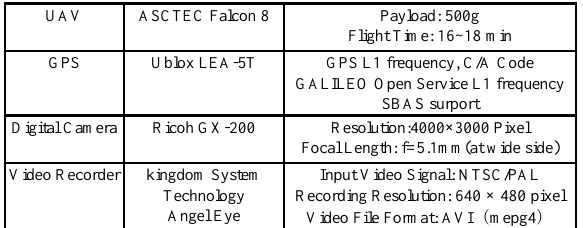
Figure 2. Flow of Automatic Exterior